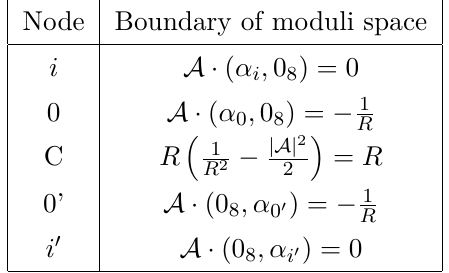
Table 3 . Equations defining the co-dimension one boundary planes in moduli space corresponding to each node of the EDD, where the nodes 0 and 0’, given in (2.13) have momentum charge (i.e. Z is that of eq.